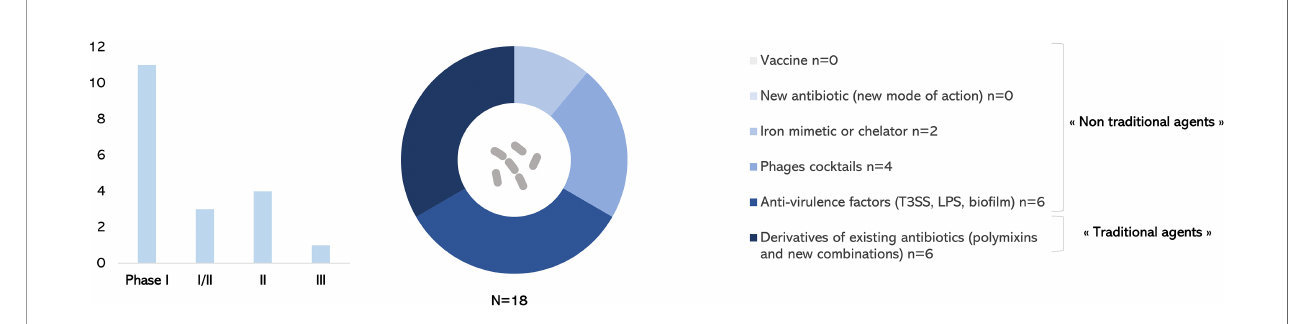
FIGURE 5 | Anti – Pseudomonas aeruginosa treatments in clinical development in December